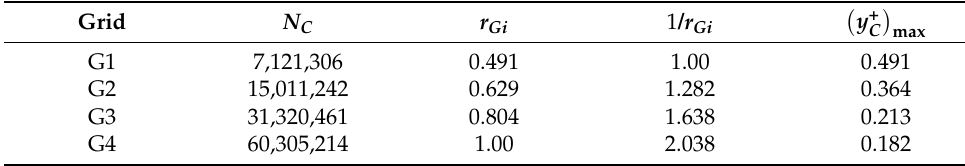
Table 3. Properties of the grid sets used in the simulations. Grid N C r Gi 1 / r